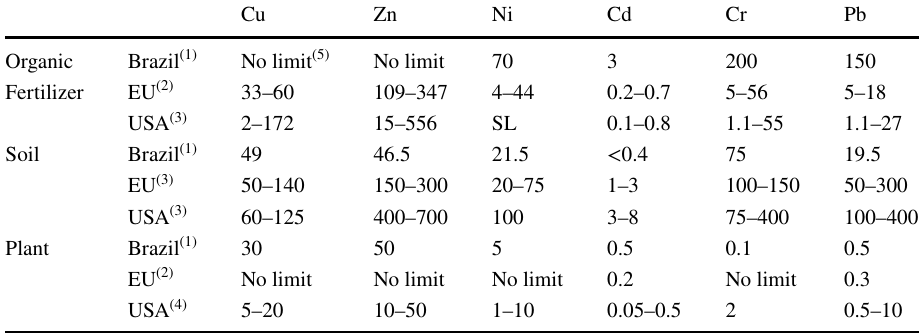
concentrations (mg kg −1 ) of heavy metals allowed in organic fertilizers, soil and plants in Brazil, the EU and the